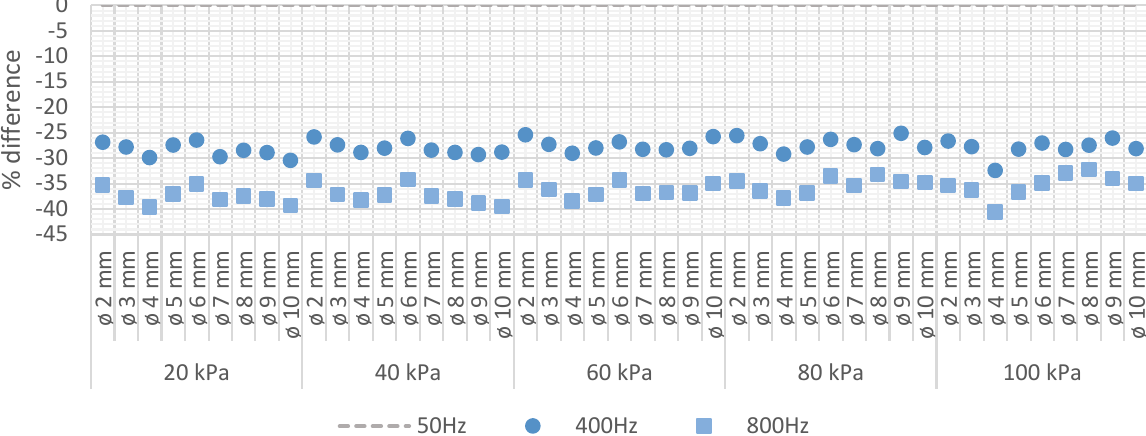
Figure 8. Corona extinction electric field strength (CEV conditions). Percentage difference at 400 Hz and 800 Hz referred to 50 Hz.